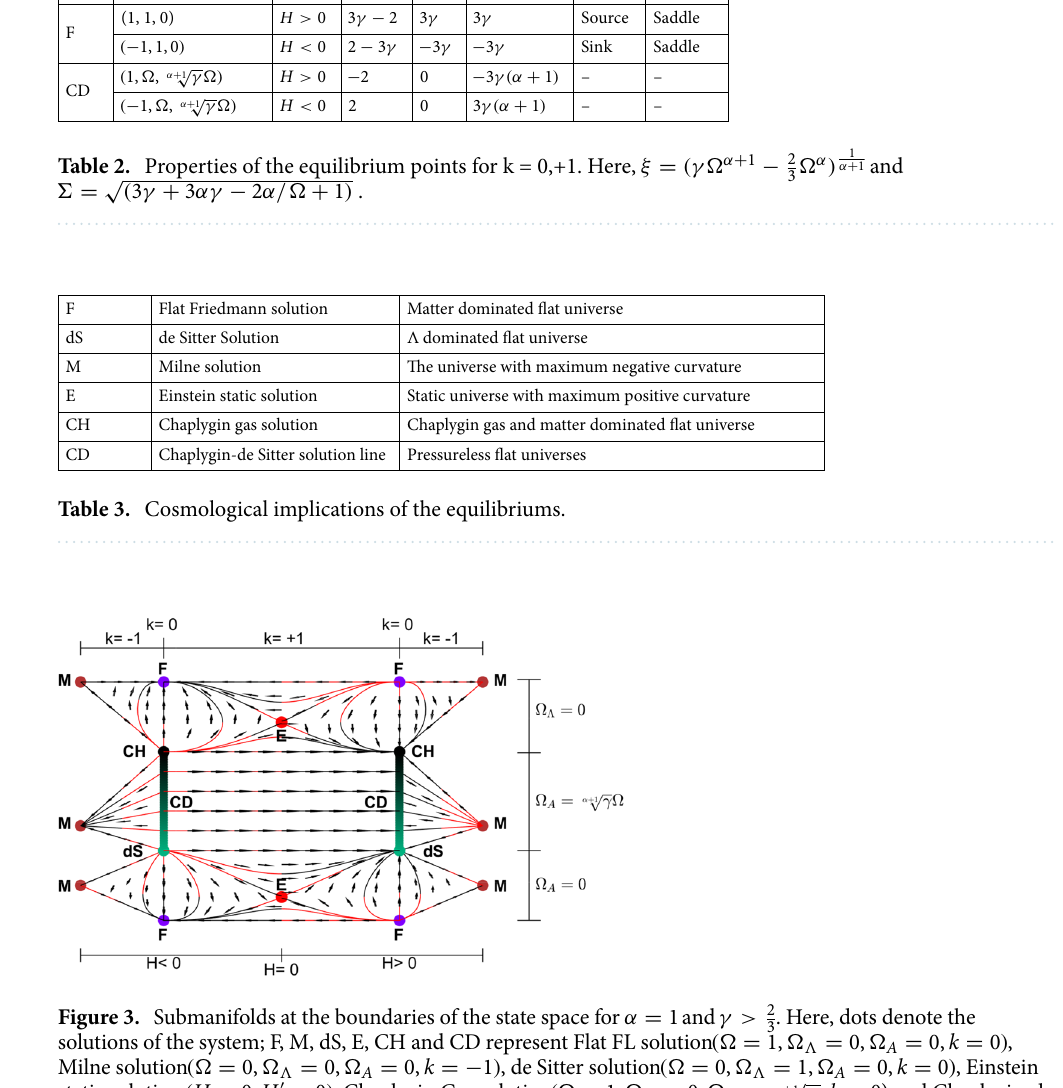
0, � � 0, � A 0, k 1 ) , de Sitter solution (� = = = = − 0, H 0 ) , Chaplygin Gas solution (� ′ = =